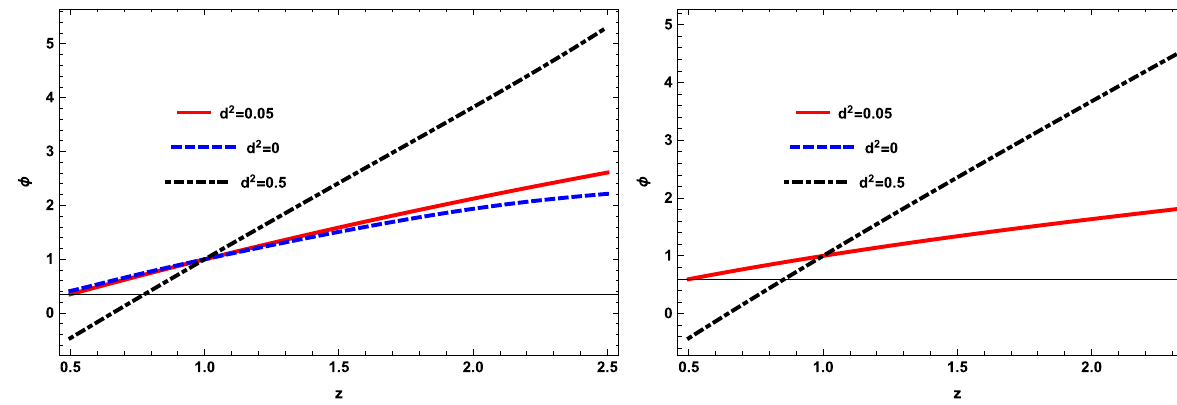
Fig. 8 Plot of φ verses z for u = 1 and u = 2 . 002 for tachyon scalar field model